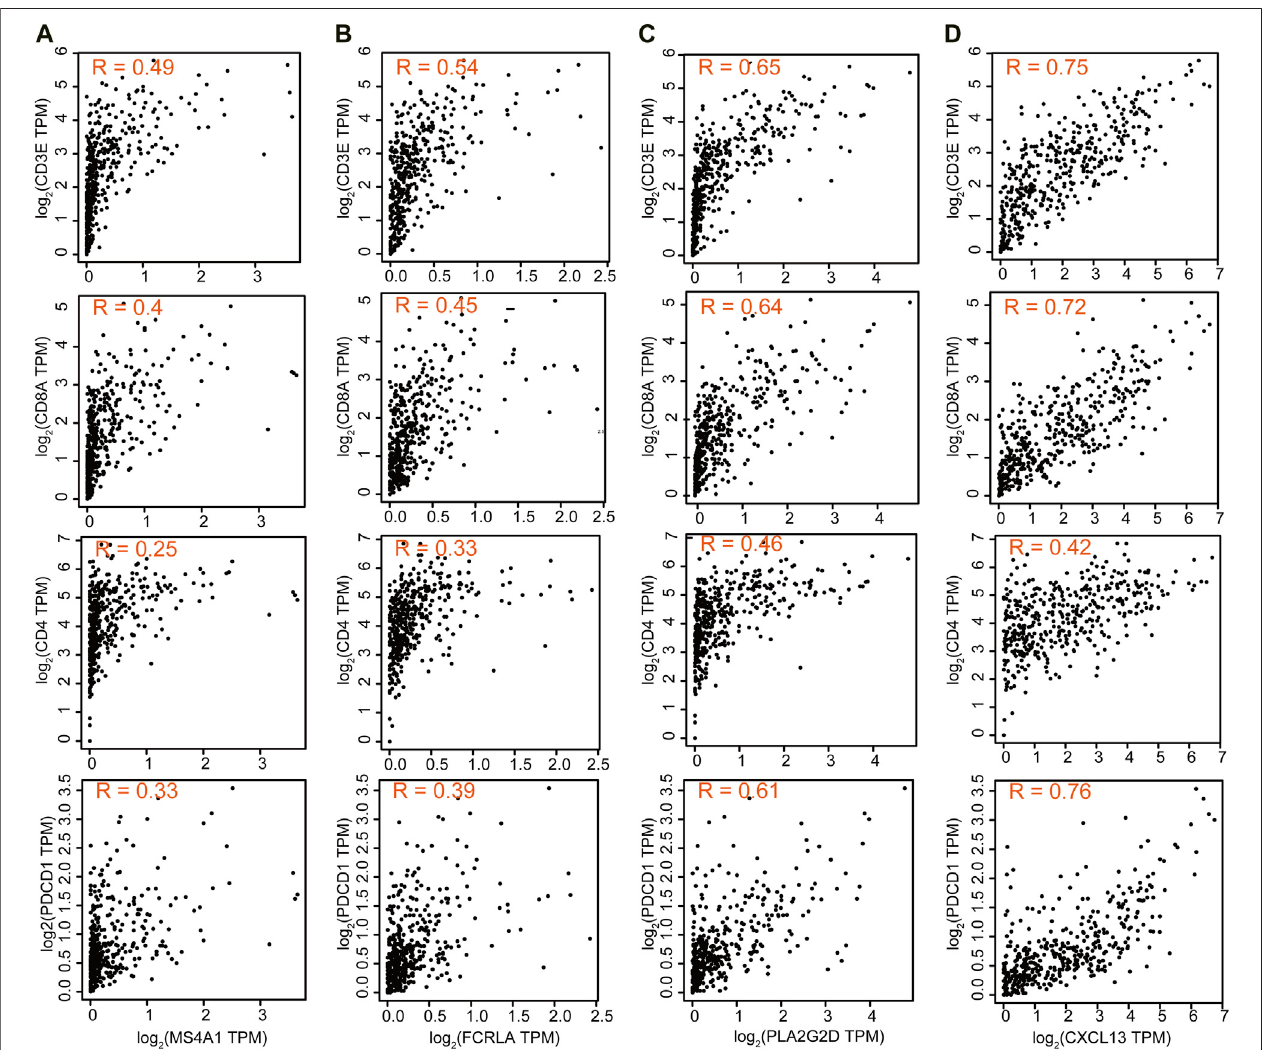
FIGURE 7| The correlation between thesefour genes and T cell-related genes. Correlation ofMS4A1 (A) , FCRLA (B) , PLA2G2D (C) , and CXCL13 (D) expression with T cell markers CD3E, CD8A, CD4, and PDCD1 from the TCGA database for OC ( n (cid:1) 379).